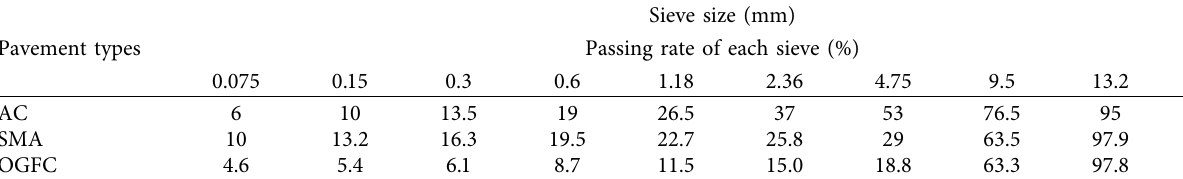
Table 3: Gradations for three kinds of asphalt pavement.